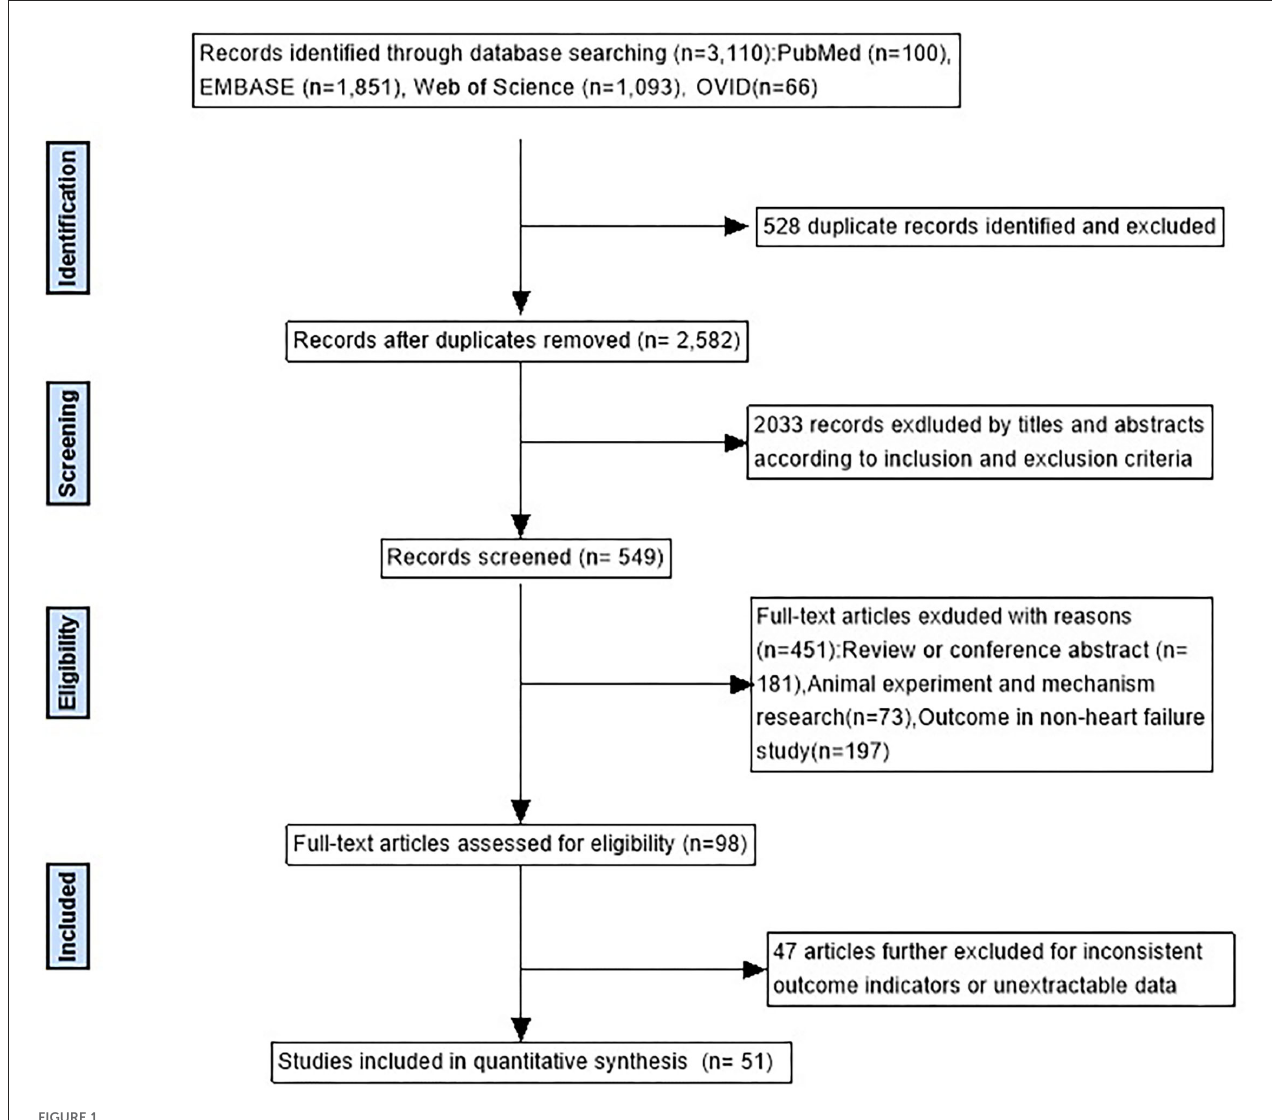
FIGURE1 A flowchart of literature